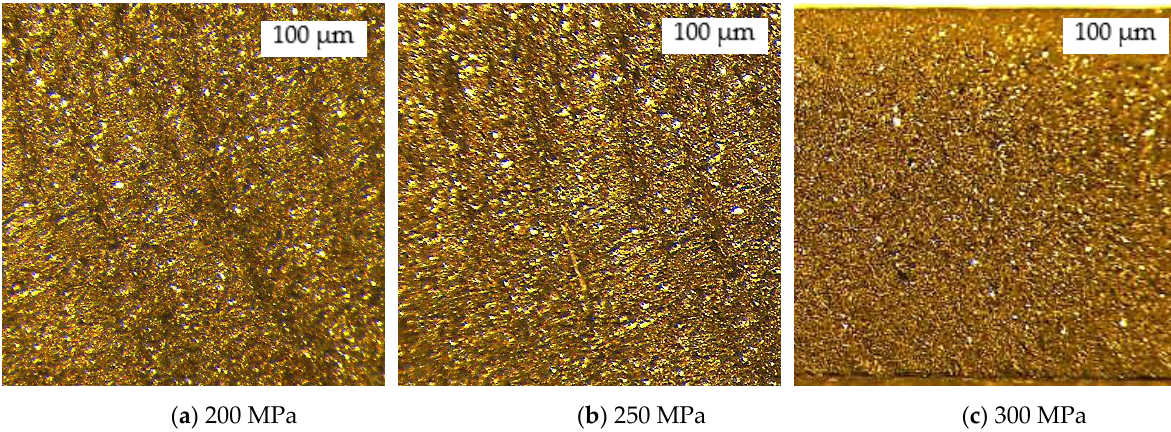
Figure 6. Topography of AISI 304L cut surface with 12 mm thickness using varied traverse speed.